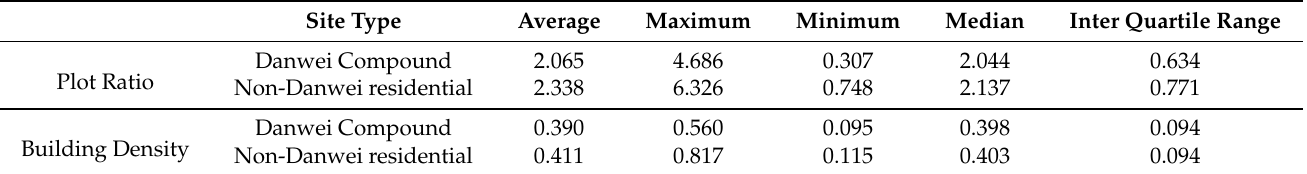
Figure 9. The Building Density Box Chart. Table 3. Key values of Figures 8 and